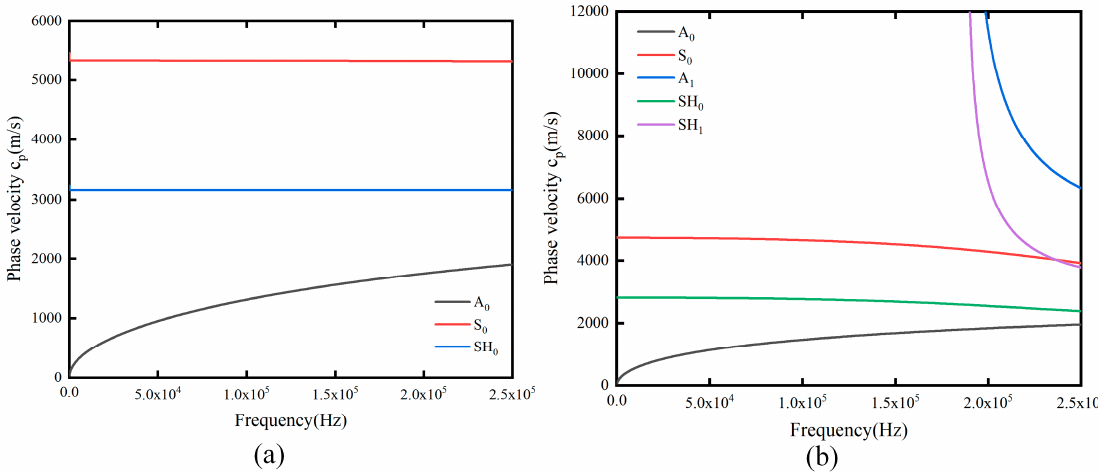
Figure 3. Phase velocity of the aluminum plate and ice-plate layered structure: ( a ) 2 mm aluminum plate, ( b ) 2 mm aluminum plate with 3 mm plate, ( b ) 2 mm aluminum plate with 3 mm ice.